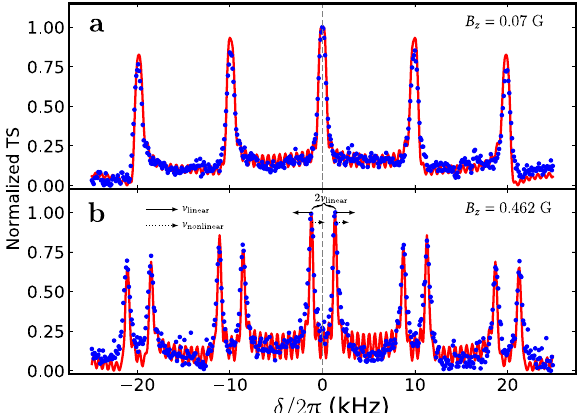
Fig. 5 Experimental TS (blue dots) under different bias magnetic fi elds B z . In the experiments, 15 periodic CPT pulses with length 2 μ s are applied during the integration time T = 1.6 ms. The numerical results (red lines) is fi tted with Ω = 2 π × 0.25 MHz. The vertical gray dash line labels δ = 0. a B z = 0.07G. b B z = 0.462G, the solid and dotted arrows respectively indicate the orientation of linear and nonlinear Zeeman